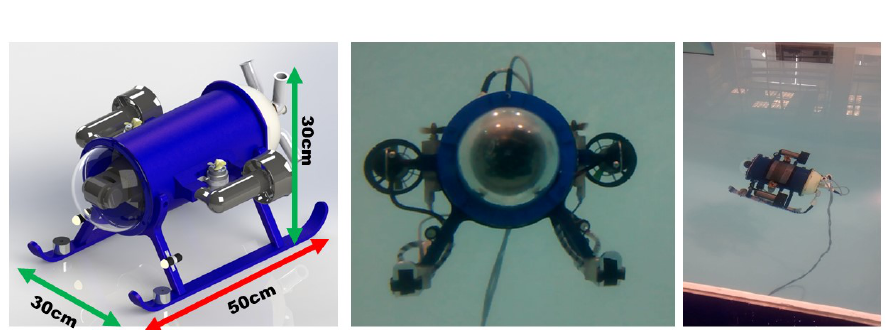
Figure 15. Underactuated mini-ROV under